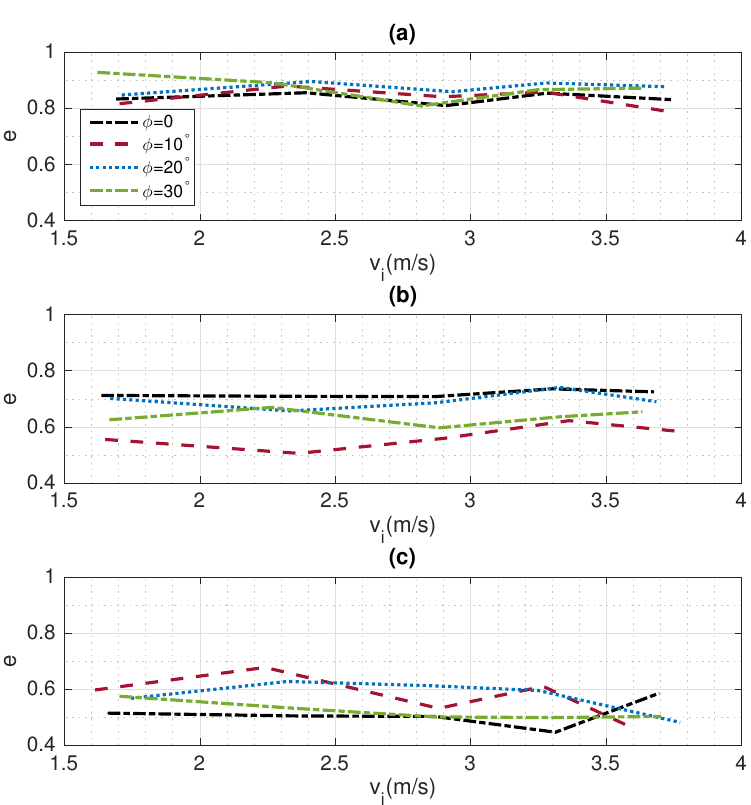
Figure 4. Mean coefficient of restitution for different impact surfaces ( a ) steel, ( b ) concrete and ( c )